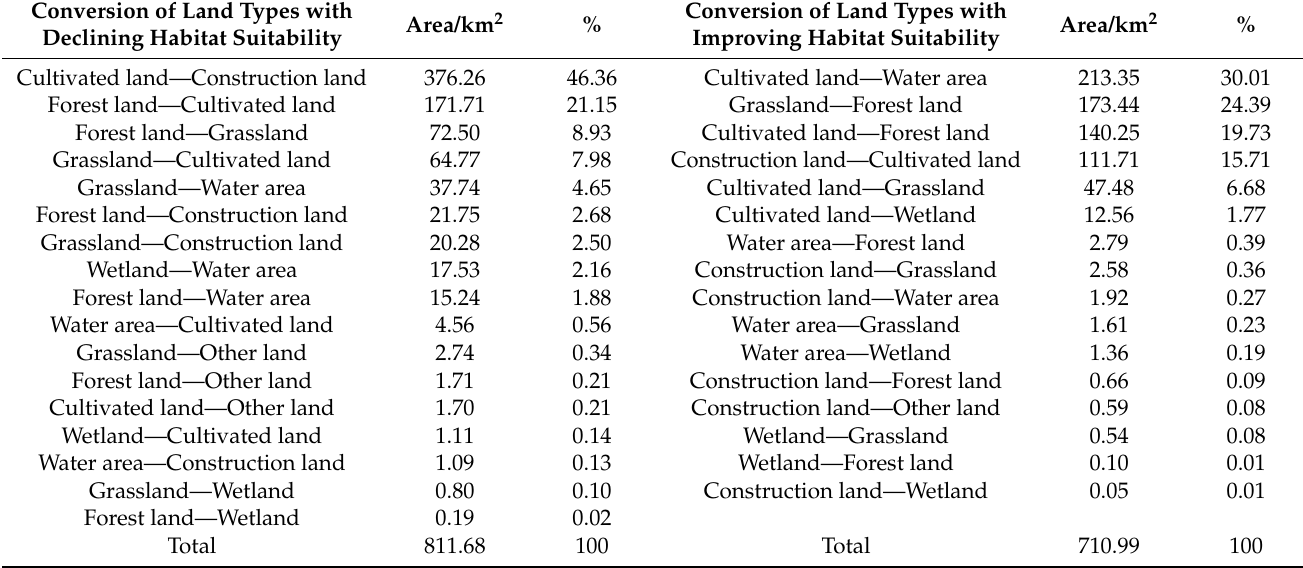
Table 9. Changes in habitat suitability of different land types in the study area from 2000 to 2020. Conversion of Land Types with Declining Habitat